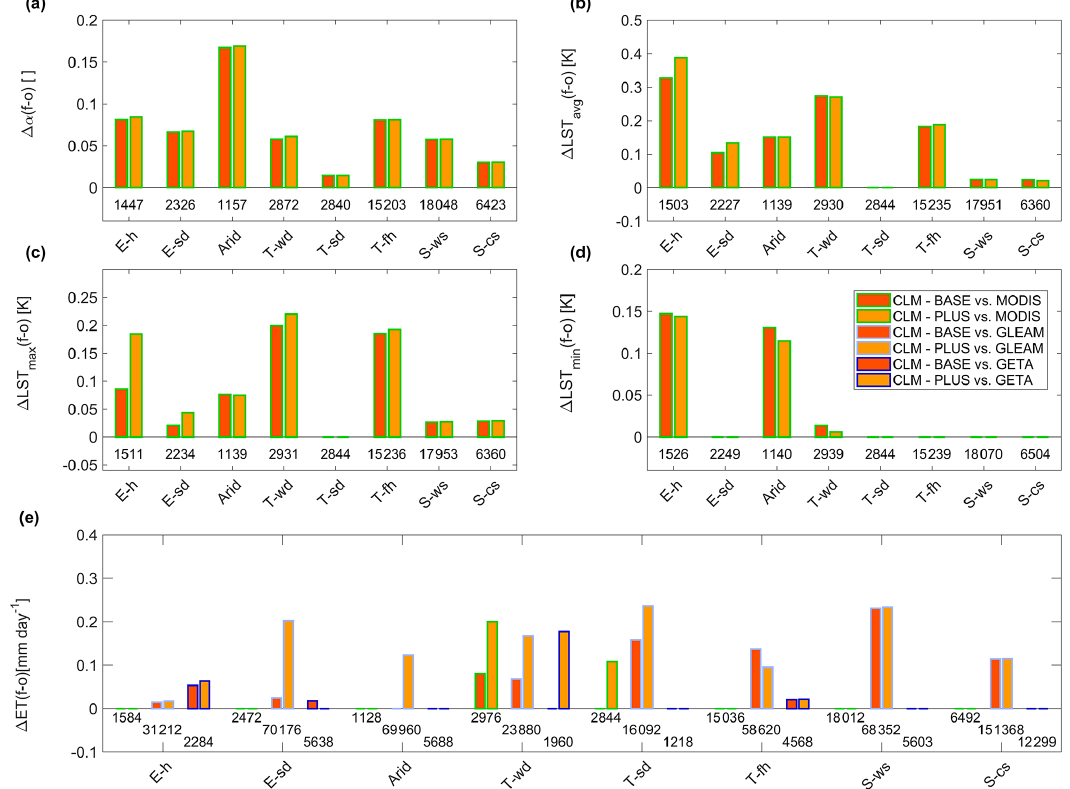
Figure A7. IA (Duveiller et al., 2016) of CLM-BASE (red), and CLM-PLUS (orange) with MODIS observations over Köppen–Geiger climate zones (Kottek et al., 2006, Fig. 1) for monthly (a) (cid:49)α(f − o) , (b) (cid:49) LST avg (f − o) , (c) (cid:49) LST max (f − o) , and (d) (cid:49) LST min (f − o) . Panel (e) shows the IA over the Köppen–Geiger climate zone for (cid:49) ET (f − o) of CLM-BASE (red), and CLM-PLUS (orange) with MODIS (green edge), GLEAM (light blue edge), and GETA (dark blue edge). The numbers indicate the size of the data samples used for the calculation of